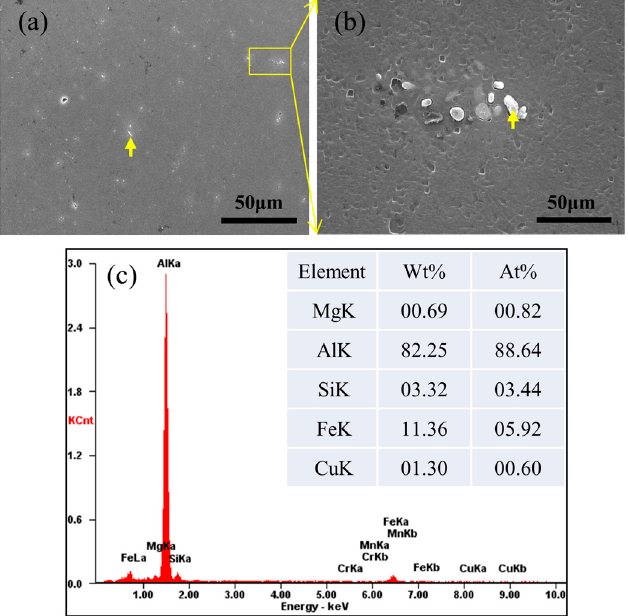
Figure 4. ( a , b ) Microstructure of the homogenized alloy; ( c ) composition of second phase.